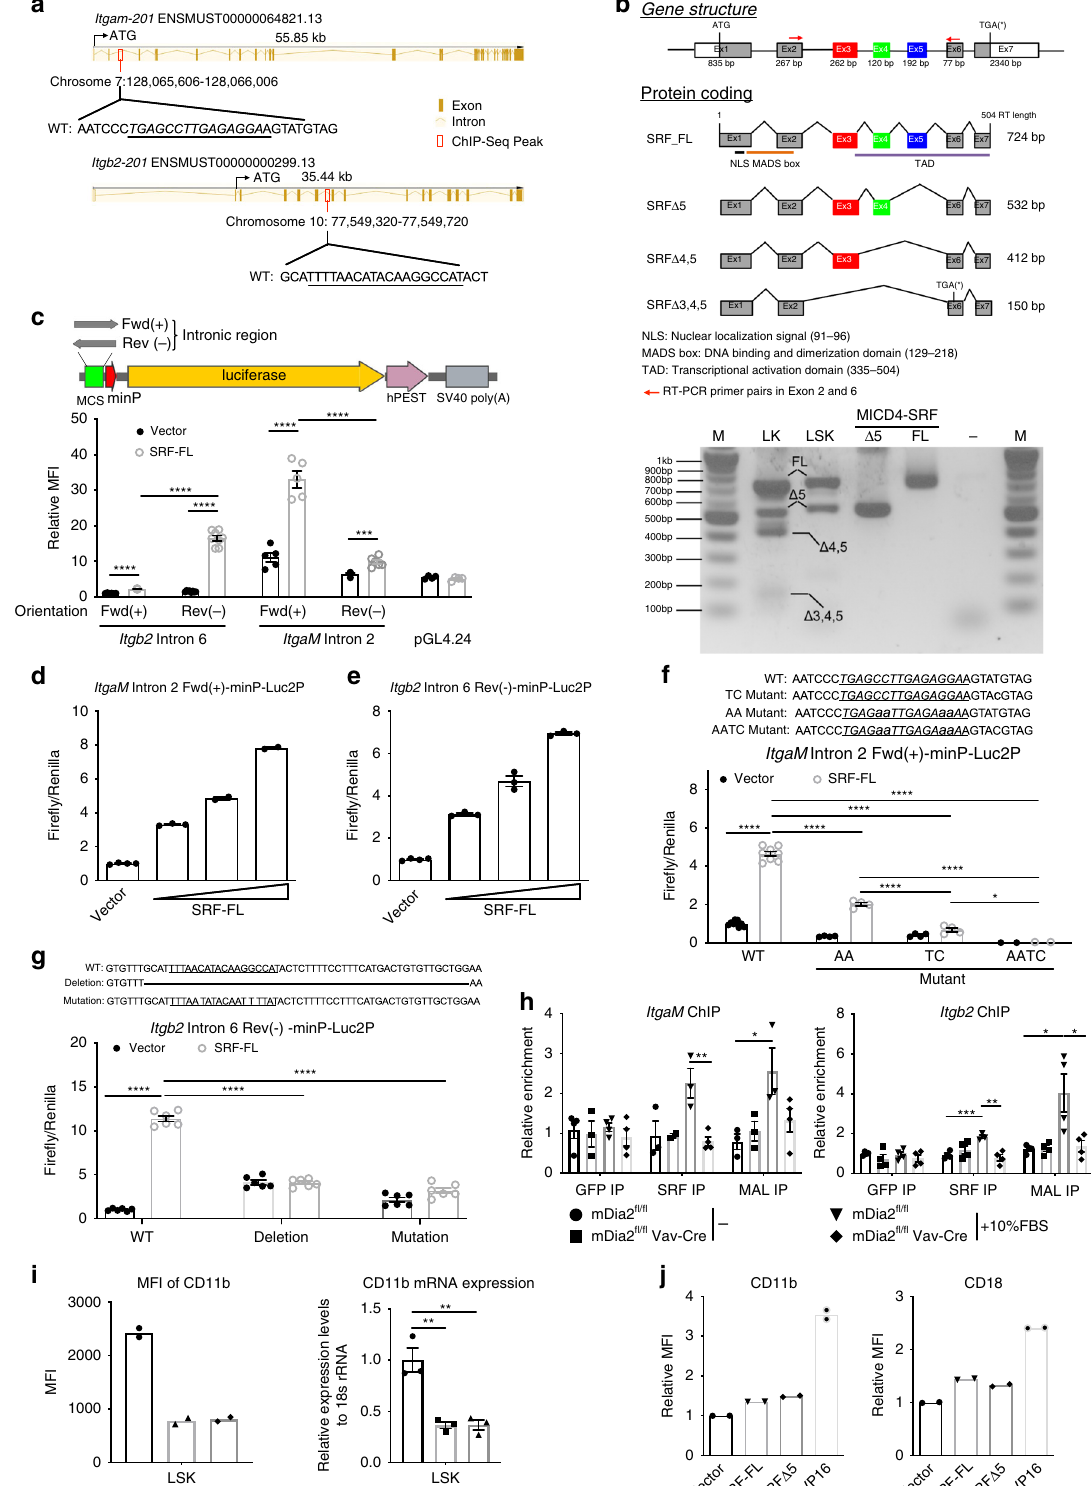
post-transplantation (Fig. 5d). Re-expression of WT mDia2 or the constitutively active mDia2 mutant ( Δ DAD) completely rescued the engraftment defects in competitive transplantation of mDia2-de fi cient HSPCs in vivo, even with low transduction ef fi ciencies (Fig. 5e and Supplementary Fig. 7f). Overexpression of both SRF-FL and SRF Δ 5 also signi fi cantly rescued the